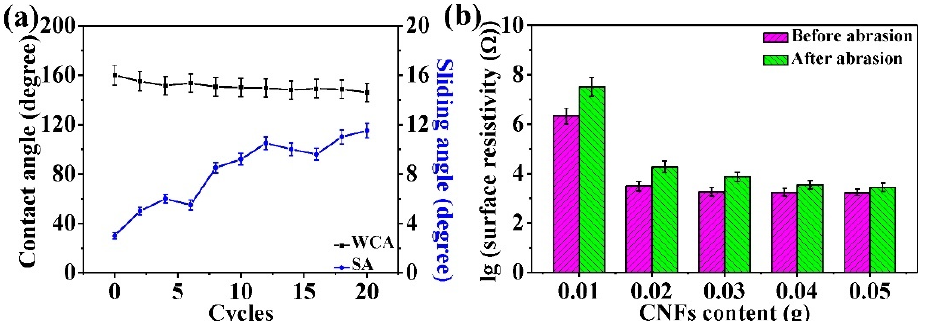
Figure 12. ( a ) Line charts of the WCA and SA of the optimized CSC coating at different abrasion cycles. ( b ) Variations in the surface resistivity of the CSC coating at different CNF contents before and after abrasion.